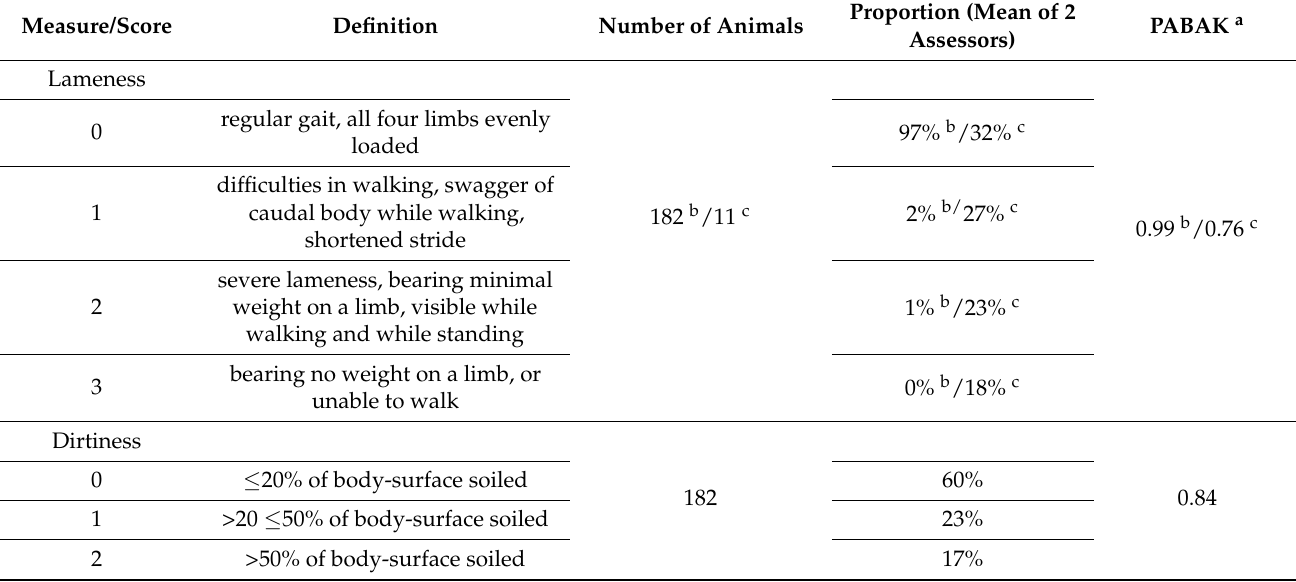
Table 4. Definitions of the scores regarding lameness and dirtiness (modified from Welfare Quality ® , 2009) and results of the inter-assessor reliability testing between two assessors (Prevalence-adjusted bias-adjusted kappa: PABAK; n = 182 pigs and 11 videos for